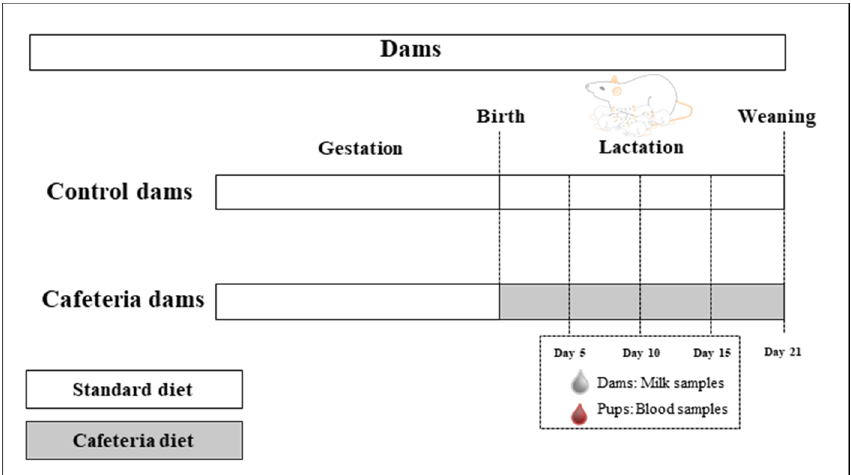
Figure 1. Representative scheme of the animal model used in this study.